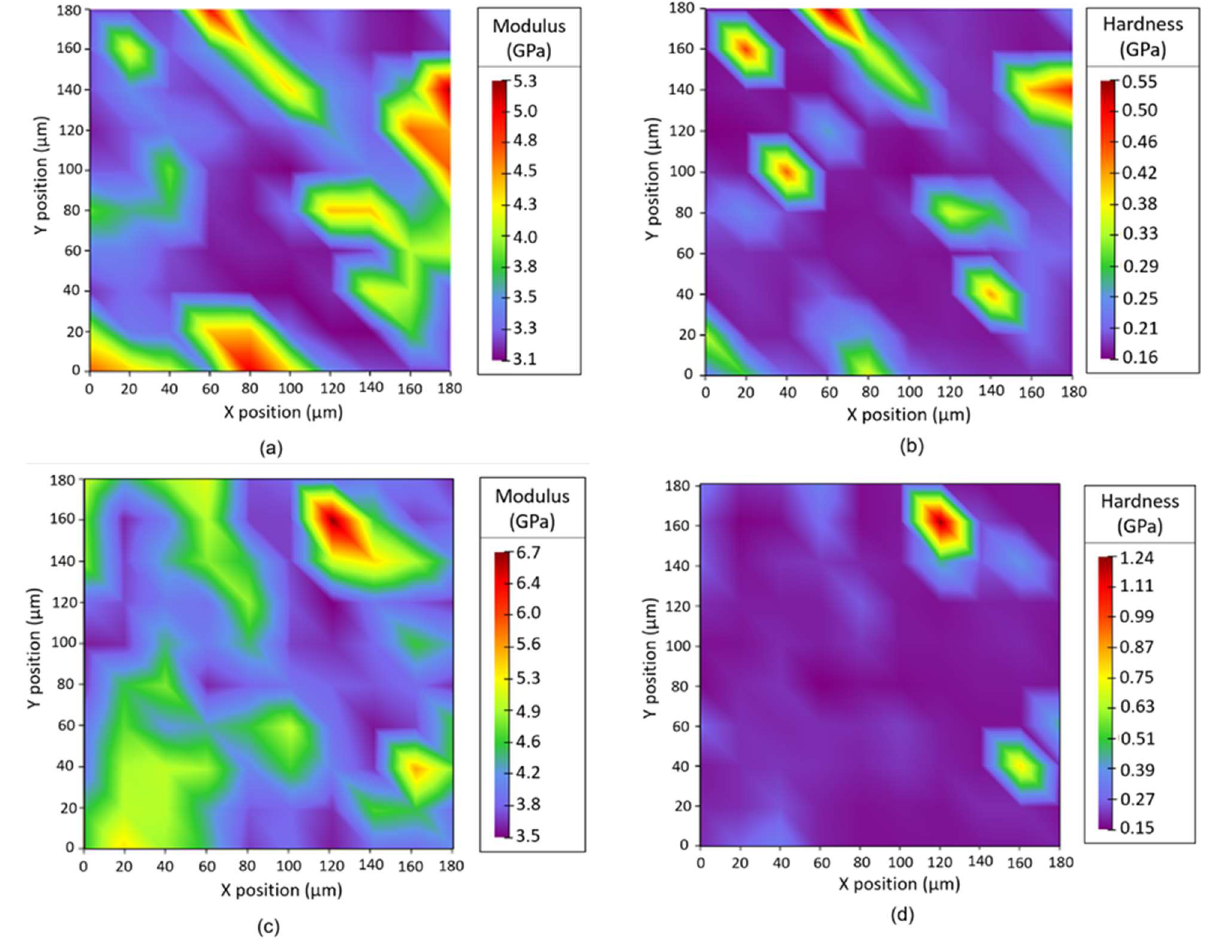
Figure 8. Example of the map of elastic modulus, En ( a , c ), and hardness, H ( b , d ), of samples CM_MCF10-CNT1 ( a , b ) and CM_MCF20-GNP3 ( c , d ).